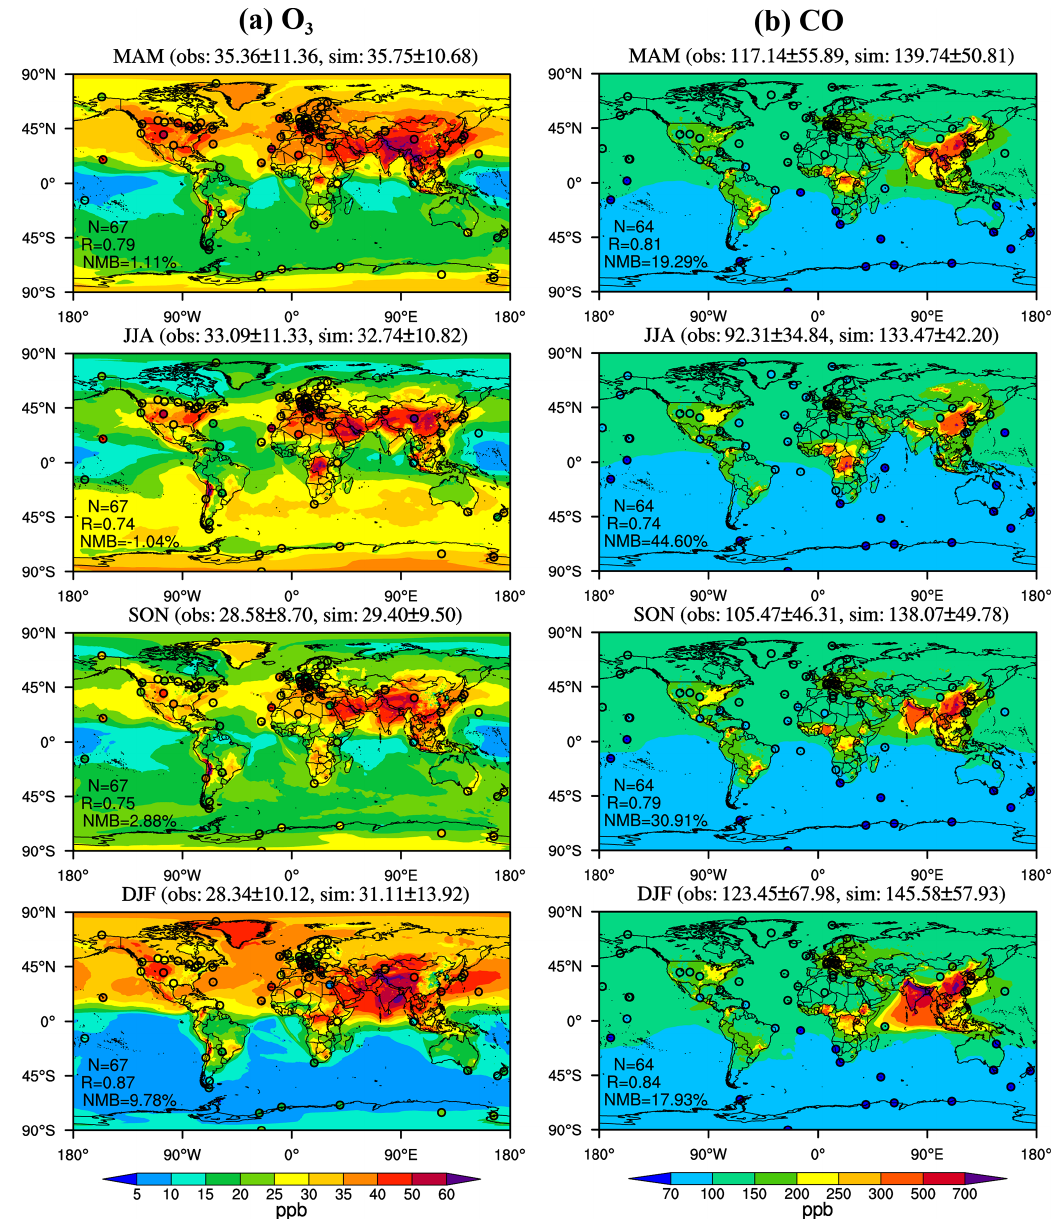
Figure 2. Spatial distributions of simulated (shaded) surface (a) O 3 and (b) CO concentrations compared with WDCGG observations (solid